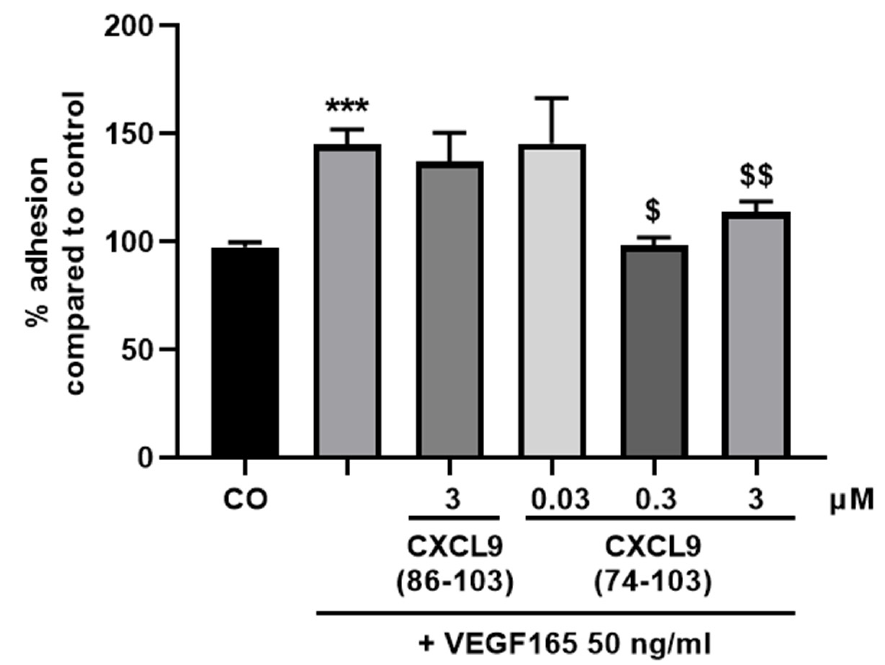
Figure 3. CXCL9(74-103) inhibits VEGF165-induced endothelial cell adhesion. HMVECs were added to gelatin-coated E-plates in the presence of 50 ng/mL VEGF165 alone or in combination with CXCL9(86-103) or CXCL9(74-103) at the indicated concentrations. The cell indices as a measure of adhesion were evaluated after 3 h. The results are expressed as a mean ( ± SEM) percentage adhesion compared to the control (100%) [ n = 2–6; Mann–Whitney U test; *** p < 0.001 (compared to control); $ p < 0.05, $$ p < 0.01 (compared to VEGF165 50 ng/mL)]. The spheroid sprouting assay is a robust in vitro angiogenesis model as it allows the study of angiogenesis in a 3D environment and shares prominent characteristics with the in vivo situation [30]. HMVEC spheroids embedded in a collagen matrix responded to FGF- 2 treatment by pronounced endothelial sprouting after 16 hours (Figure 4). The number of sprouts, as well as the sprout length of FGF-2-treated spheroids, were diminished when spheroids were incubated with 3 µ M of CXCL9(74-103). CXCL9(86-103) at 3 µ M had no effect on sprout outgrowth induced by FGF-2. Altogether, these in vitro data show that CXCL9(74-103), but not CXCL9(86-103), can interfere with growth factor-induced processes including endothelial cell prolifera- tion (VEGF, FGF-2, EGF), migration (VEGF, FGF-2, EGF), adhesion (VEGF) and spheroid sprouting